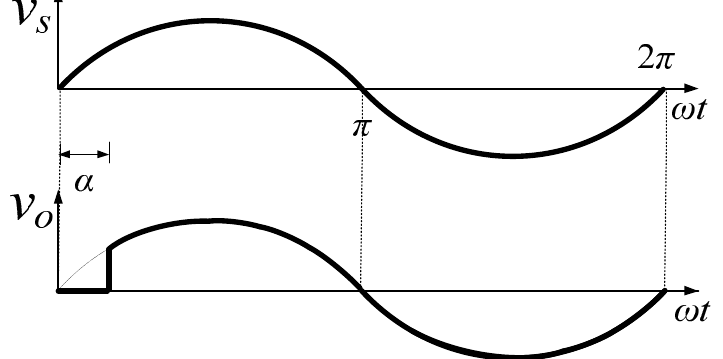
Figure 2. Output RMS voltage control through unipolar phase-angle control.